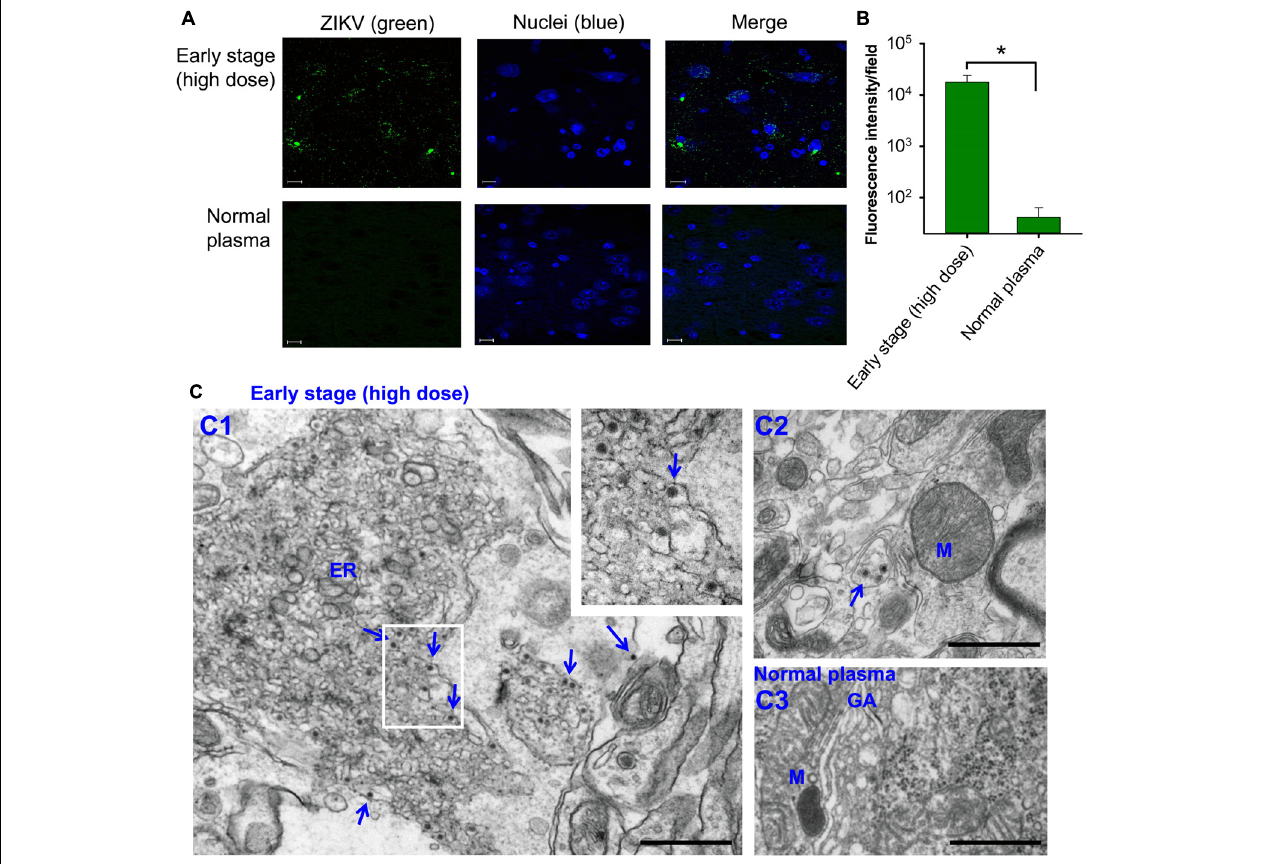
FIGURE 3 | Identification of ZIKV particles in brain tissues of pregnant A129 (E10–12) mice transfused with early-stage (high dose) ZIKV + plasma. (A) Immunofluorescence staining of brain tissues collected 6 days post-transfusion. Brain sections were stained for ZIKV (green) using ZIKV EDIII-specific mAb ZV-64, and representative images are listed. Nuclei were stained with DAPI, and are shown in blue. Magnification: 63X; Scale bar: 10 µ m. (B) Quantification of ZIKV staining in (A) was calculated by ImageJ software for the relative intensity (particle analysis) of ZIKV staining with fluorescent signals. The data are presented as mean fluorescence intensity (e.g., ZIKV + staining) in each field ± s.e.m ( n = 6, “ n ” indicates numbers of image from different brain tissues), and ∗ indicates significant differences between early stage (high dose) and normal plasma groups. (C) TEM analysis of above brain tissues. Microphotographs of ZIKV particles formed in brain tissues of mice transfused with early-stage (high dose) ZIKV + plasma (C1–C2) or normal plasma (C3). Short arrows indicate ZIKV particles. ER, endoplasmic reticulum; M, mitochondria; GA, golgi apparatus. Scale bar: 500 nm. Normal plasma groups (A–C) indicate control mice transfused with normal plasma without